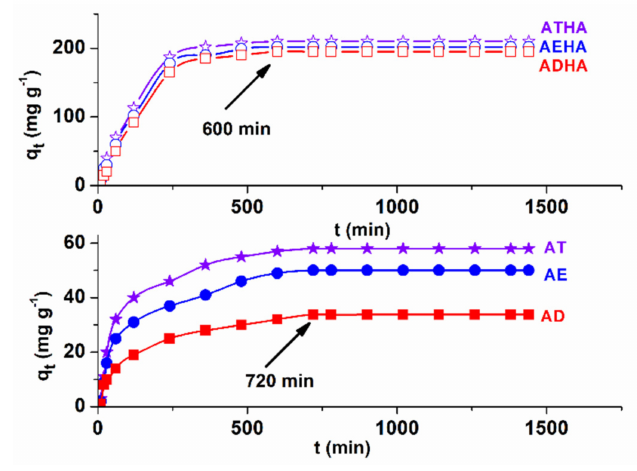
Figure 11. Influence of contact time on the adsorption capacity of metronidazole on precursor/hybrid microparticles.